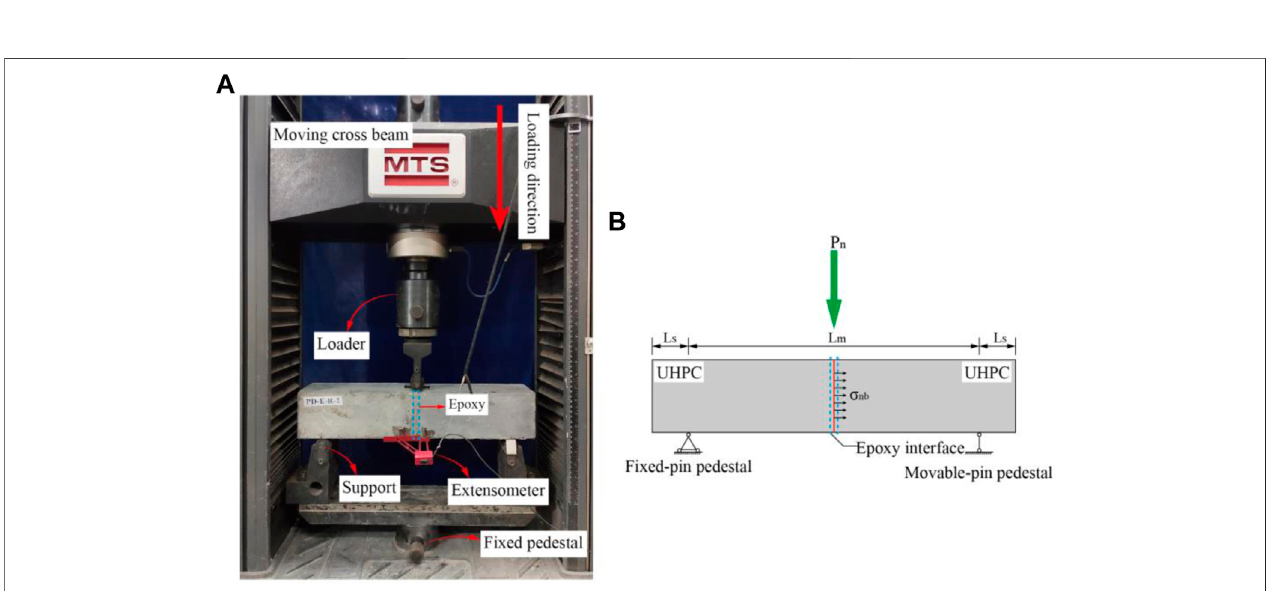
FIGURE3| Theproductionprocessofthespecimen. (A) Formworkmaking. (B) UHPCpouring. (C) Steamcuring. (D) Interfacetreatment. (E) Formingspecimens. (F) Epoxy painting.